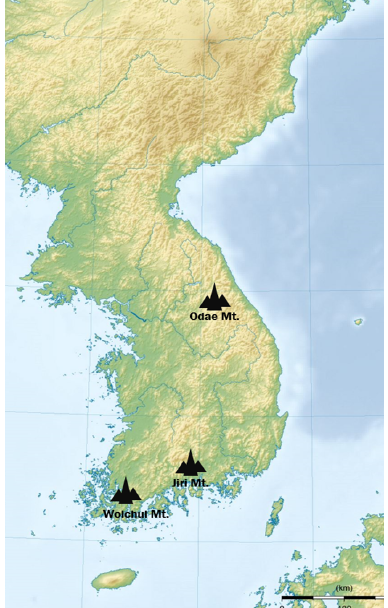
Figure 1. The map showing the collection sites of three accessions (Wolchul, Odae, and Jiri mountains) of Thymus quinquecostatus in South Korea.